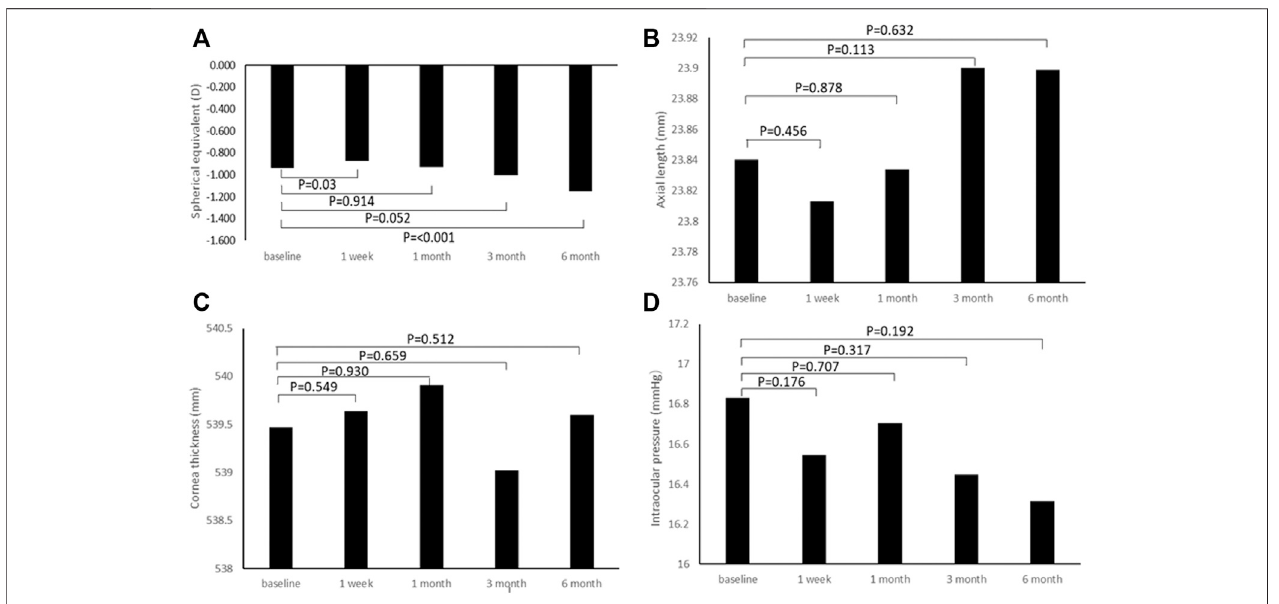
FIGURE 1 | Change in biometric parameters after the instillation of 0.01% atropine eye drops. (A) Spherical equivalent. (B) Axial length. (C) Cornea thickness. (D) Intraocular pressure.